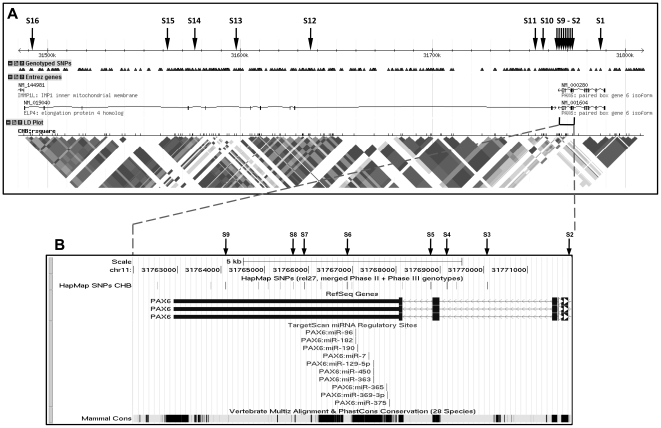
Distribution of 16 single nucleotide polymorphisms (SNPs) in the PAX6 region.The PAX6 region under study spans a genomic region of 324.6 kb (chr11: 31,484,873..31,809,434) together with different interesting features. Please refer to Table 1 for the rs numbers of the SNPs. (A) The top panel shows the physical positions (+ strand) of the 16 SNPs (S1 to S16, right to left) in the region under study, followed by positions of the SNPs genotyped by the HapMap project, the Entrez genes (ELP4 and PAX6) and the linkage disequilibrium (LD) pattern (r2) for HapMap Han Chinese. Note the low LD region in the 3′ end of the PAX6 gene. (Source: http://hapmap.ncbi.nlm.nih.gov/index.html.en) (B) A closer view of the 10-kb region in the 3′ end of the PAX6 gene, the binding sites for ten micro-RNAs as predicted by the programme TargetScan, and the sequence conservation across 28 mammalian species. (Source: http://genome.ucsc.edu/cgi-bin/hgGateway).